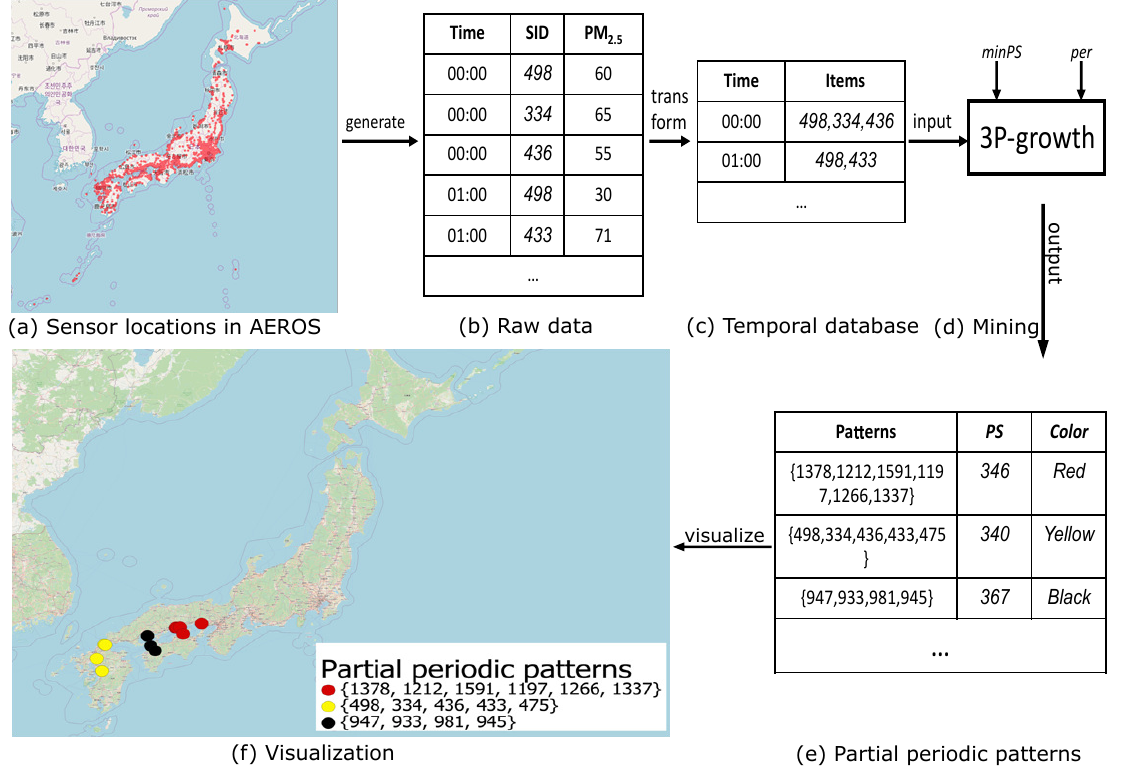
Figure 9. Air pollution data analytics ( a – f ). The term SID stands for sensor